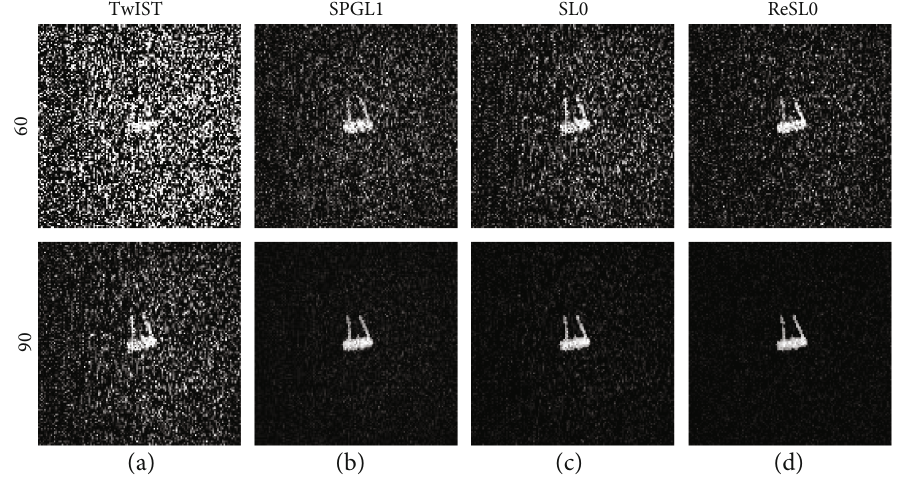
Figure 8: The reconstruction results from 60-view and 90-view experiment data, respectively. (a – d) Results of TwIST, SPGL1, SL0, and ReSL0